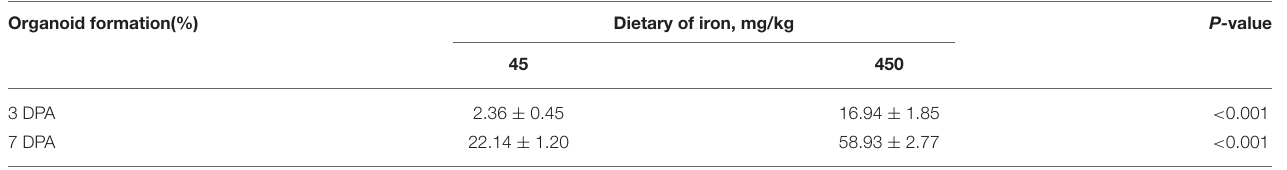
TABLE 2 | Effects of dietary iron on organoid formation rate of adult mice after repair¹. Organoid